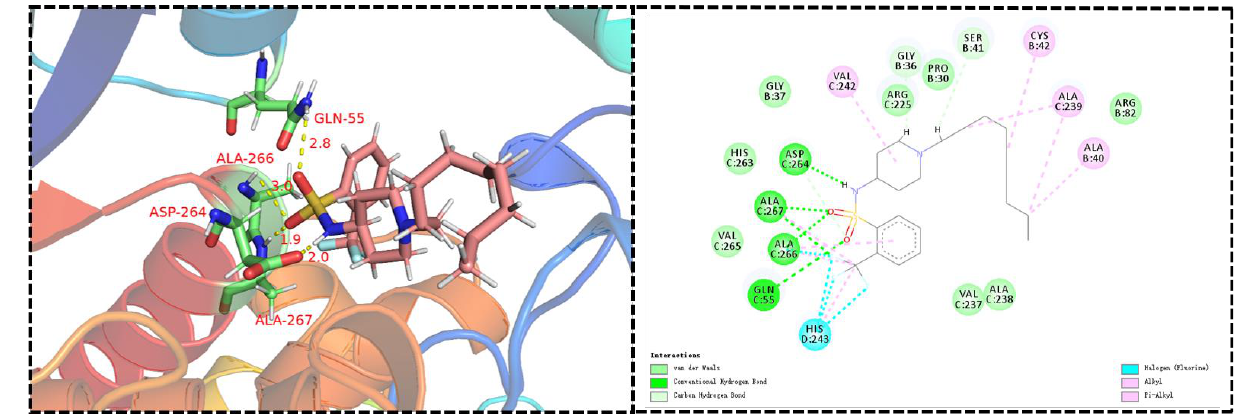
Figure 4. Predicted binding mode and interactions. Molecular docking of compound C 4 with DHPS. (PDB: 6DAY).